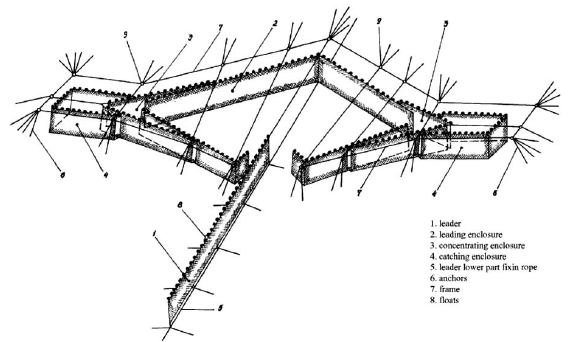
Fig. 2. – Giant pound net to be installed at 9-12 m depth.